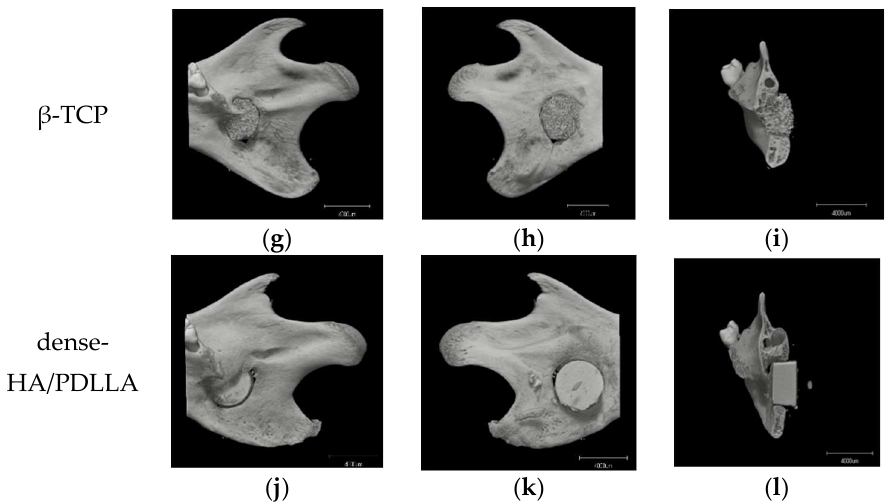
Figure 6. Micro-CT results of the critical bone defect model at 4 weeks after implantation. No obvious bone formation is seen in the sham group. In the 3D-HA/PDLLA and β-TCP groups, some parts of the border between composites and bone cannot be clearly discerned such as ( f , i ), unlike in the dense-HA/PDLLA group. Scale bar: 4000 μm.